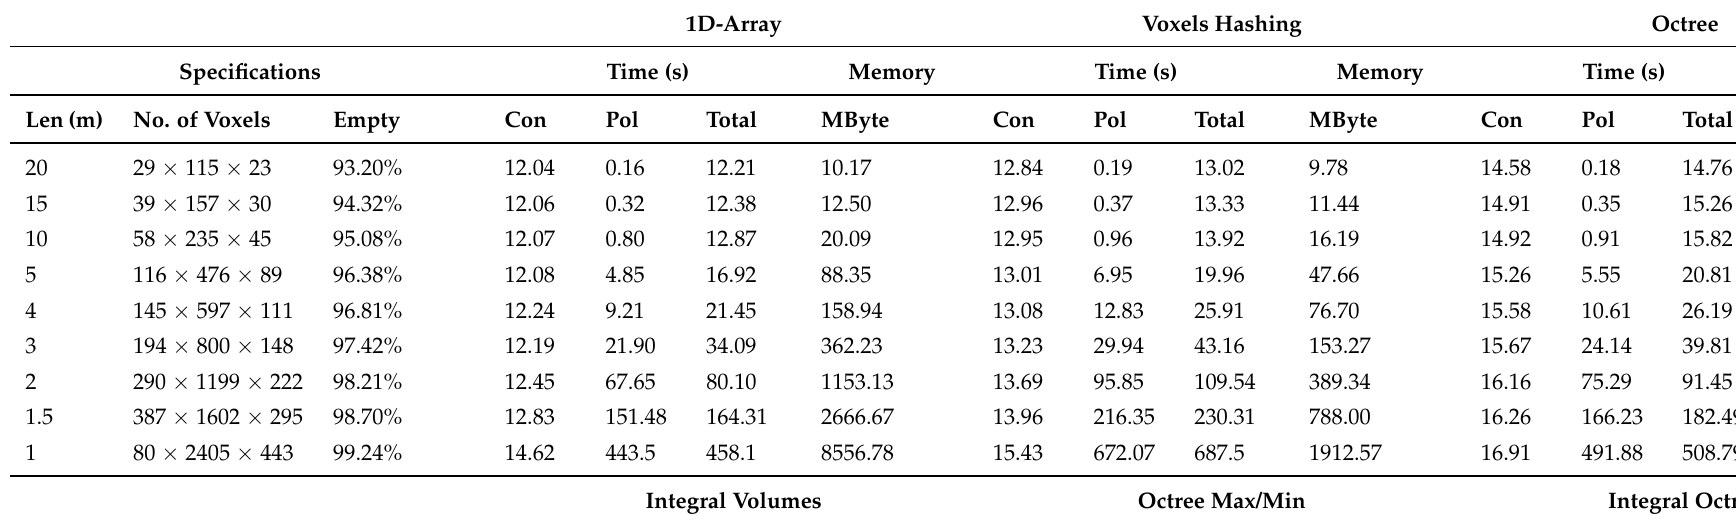
Table 4. Results: Execution time and memory consumption, Con = Construction, Pol = Polygonisation, MByte = Max Memory, Len = Voxel Length that relates to the resolution of the